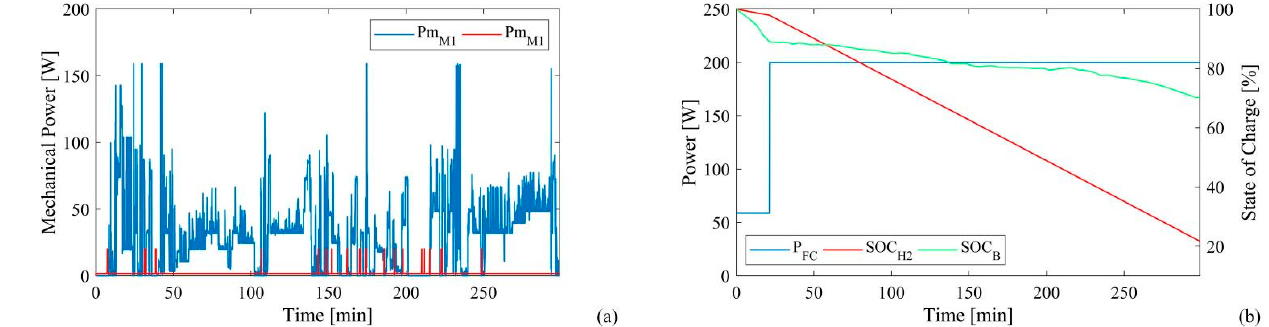
Figure 9. AMV performance in Journey 1: ( a ) Motor mechanical power trends; ( b ) Fuel cell power, hydrogen tank and battery state of charge trends.